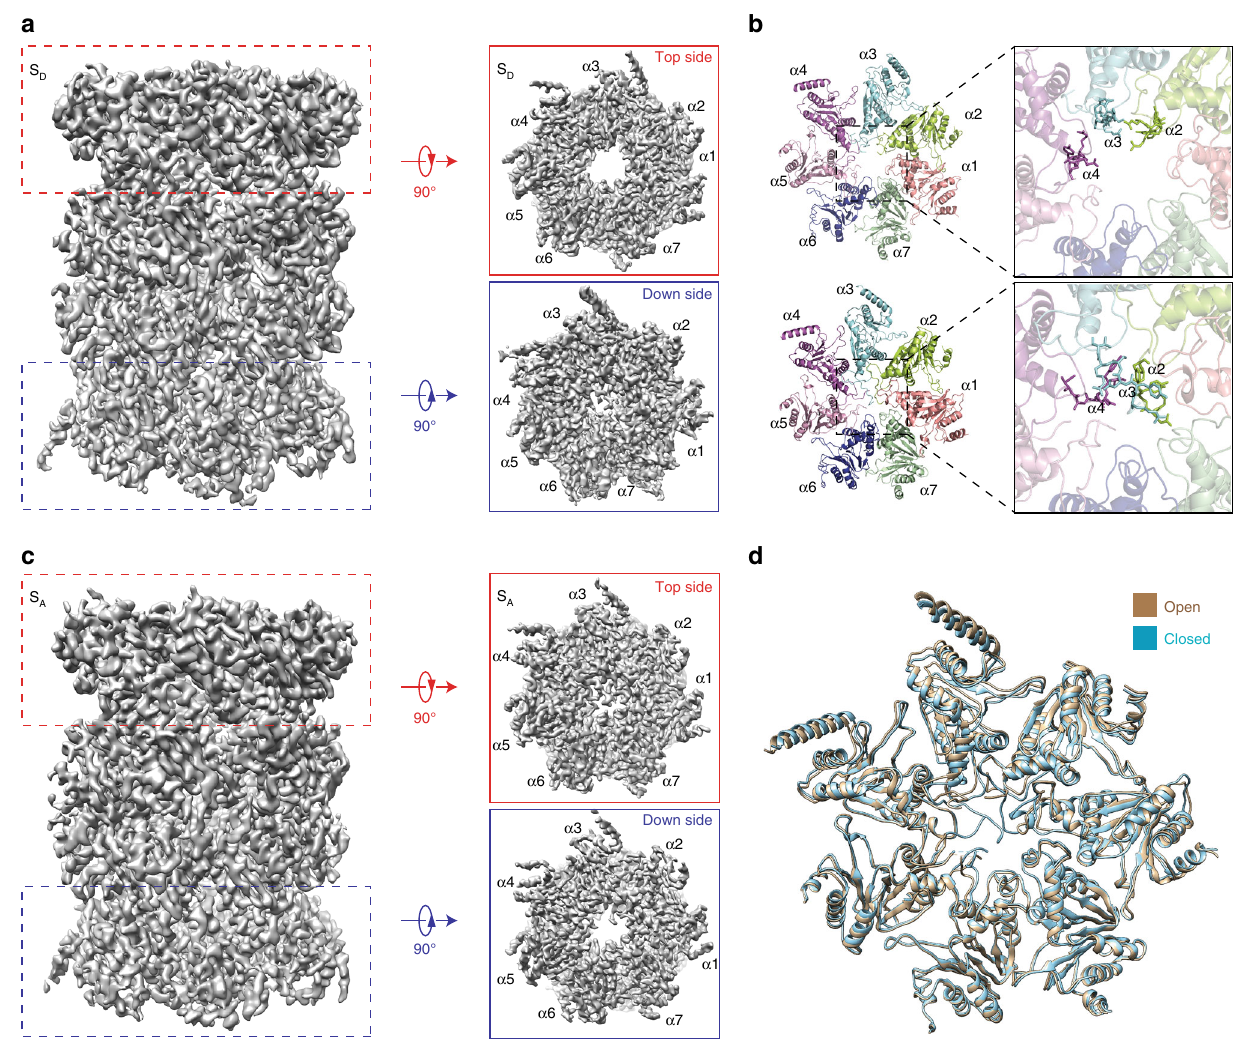
Fig. 2 Asymmetric opening of the CP gates corresponding to the S A and S D states of the RP – CP subcomplex. a The side view (left), top view (upper right), and bottom view (lower right) of the CP density map in the combined S D state. The upper half of the CP is associated with the RP in the S D state of the RP – CP subcomplex. b The atomic models of two different α -rings from the perspective of the AAA-ATPase or the RP – CP interface in S D in a cartoon representation (left). Close-up view of the central parts of the α -rings, showing that the CP gate is open on the top (upper right) and closed on the bottom (lower right). c The side view (left), top view (upper right), and bottom view (lower right) of the CP density map in the S A state. The upper half of the CP is associated with the RP in the S A state of the RP – CP subcomplex. d Superimposed atomic models of two different α -rings in a cartoon representation in the S D state colored light orange (closed) and light blue